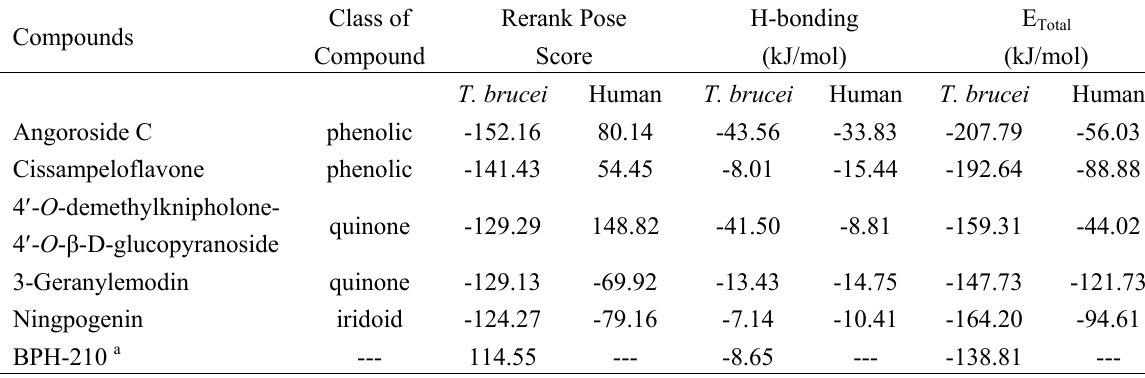
Table 2. Top hit compounds for docking to farnesyl diphosphate synthase (FDS). Compounds